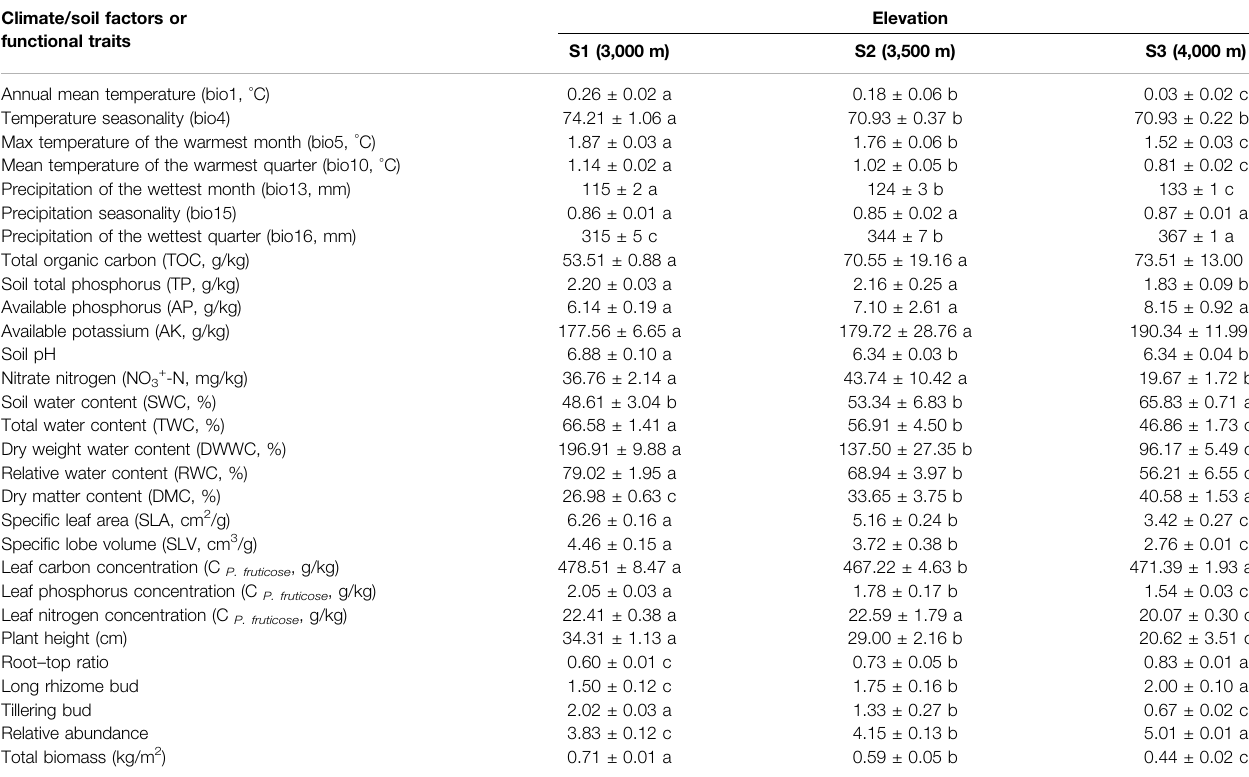
TABLE 1 | Analysis of variance for soil variables, climate variables, and functional traits. Climate/soil factors or functional